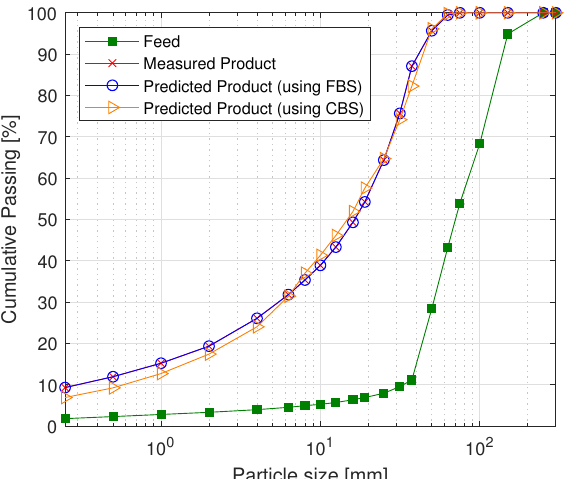
Figure 4. Measured and predicted PSD curves to compare the effect of the number of degrees of freedom of the breakage function on the model accuracy for dataset